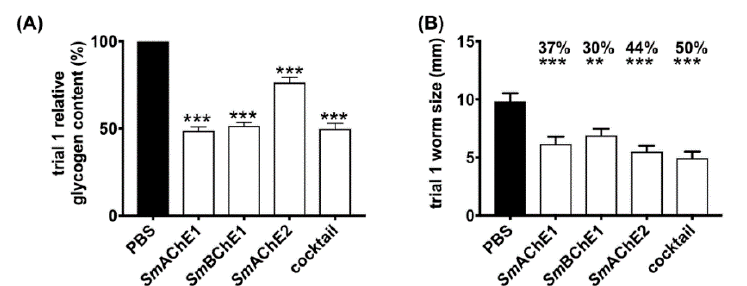
Figure 5. Effect of Sm ChE vaccination on glycogen storage in, and the size of, S. mansoni adult worms. ( A ) Triton-X-100 extracts were made from five pairs of worms freshly perfused from each vaccinated or control group and the glycogen content in these extracts was measured. Plotted data are the average of triplicate biological and technical experiments ± SEM. ( B ) Worm sizes (mm) were assessed by randomly selecting and measuring (ImageJ) at least 20 worms from each group. Significance and percent reductions (if any) for both parameters were measured relative to the control group. Differences for both experiments were measured by the student’s t test, where ** p ≤ 0.01 and *** p ≤ 0.001.